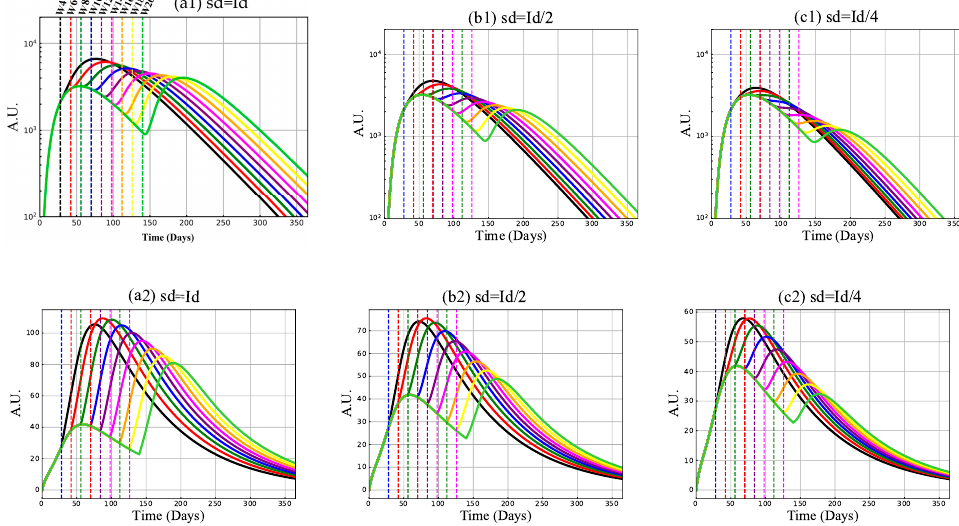
Figure 4. Antibody (IgG) and CTL outcomes with standard (SD) and low dose (LD), with and without delay. Model predictions of antibody, first row, and cytotoxic T-cells, second row, with second dose vaccination on days: 28 (week:4), 42 (week:6), 56 (week:8), 70 (week:10), 84 (week:12), 98 (week:14), 112 (week:16), 126 (week:18), and 140 (week:20, shown by colored vertical dashed lines.). The second dose value (sd) in panel ( a ) is the same as the initial dose (id) value: (sd = Id = 1000 vaccine particles), in panel ( b ) it is decreased by half (sd = Id/2 = 500 vaccine particles), and in panel ( c ) is decreased by a quarter (sd = Id/4 = 250